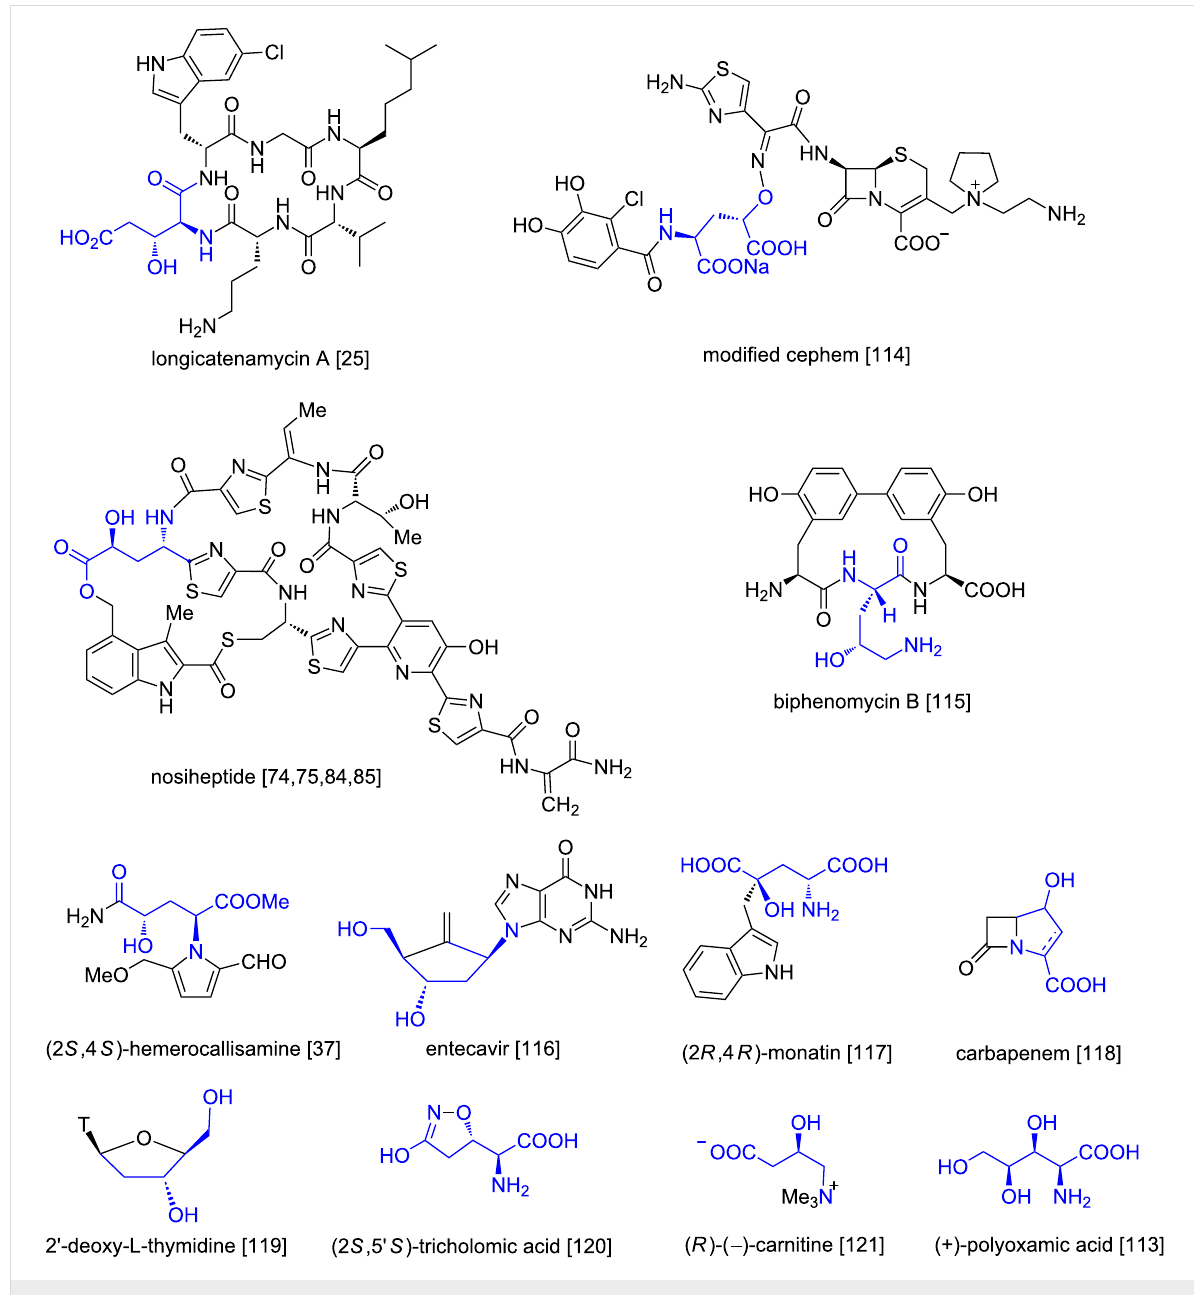
Figure 6: Structures of selected compounds containing hydroxyglutamic motives (in blue).